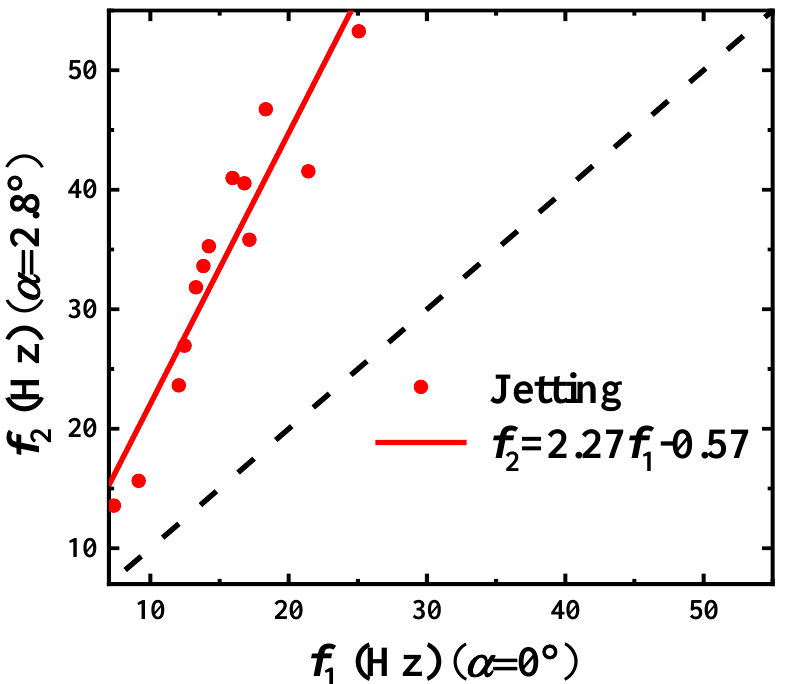
Figure 12. The correlation test of the paraffin droplet forming frequencies between f 1 for α = 0 ◦ and f 2 for α = 2.8 ◦ in the Jetting